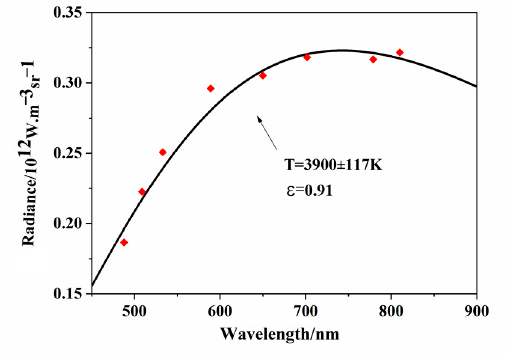
Figure 6. The fitting temperature and fitting error.